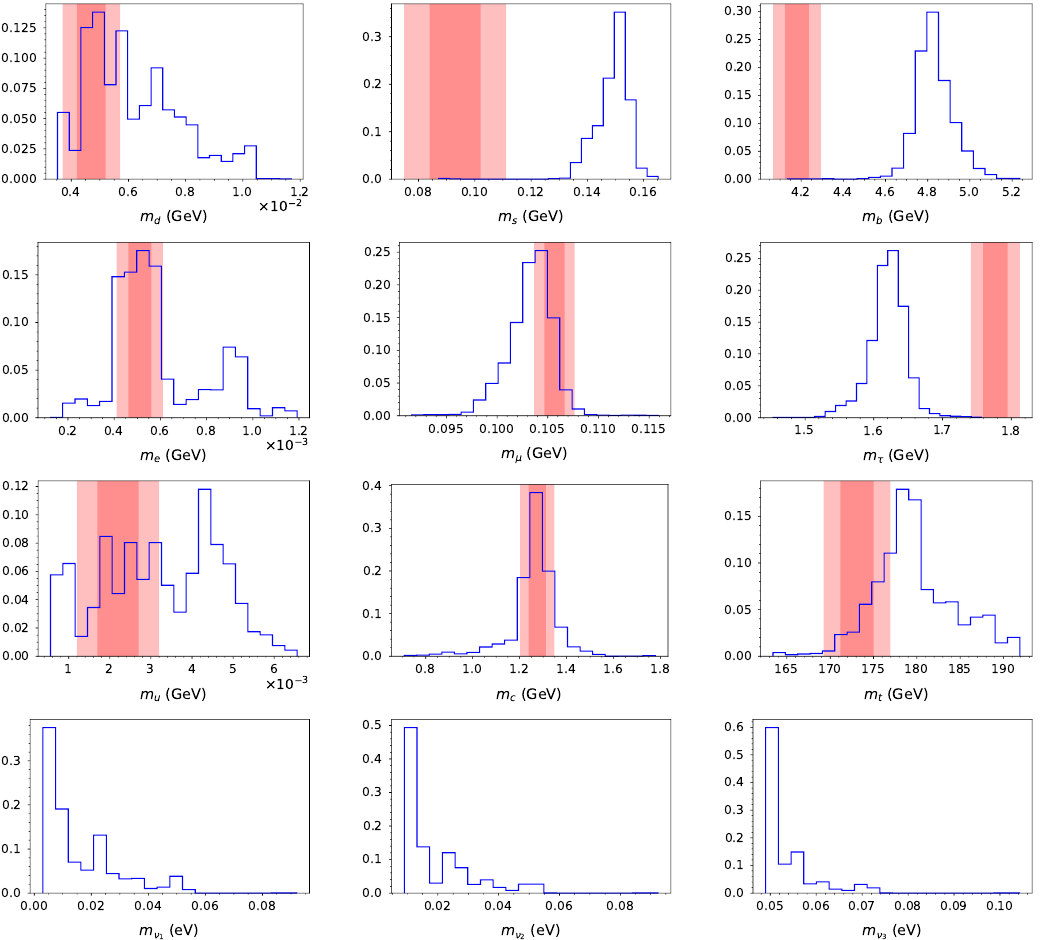
Figure 4 . The fermion masses are displayed where the red (light red) region indicating the 1 σ ( 2 σ ) limits. The first generations are very well fitted. However, due to the link between the down type quarks and the leptons at the GUT scale, the second and third generation masses are slightly off. Furthermore, the top mass is also slightly poorly aligned due to the Higgs mass constraint. Note that few points exhibit neutrino masses above the visible part of the